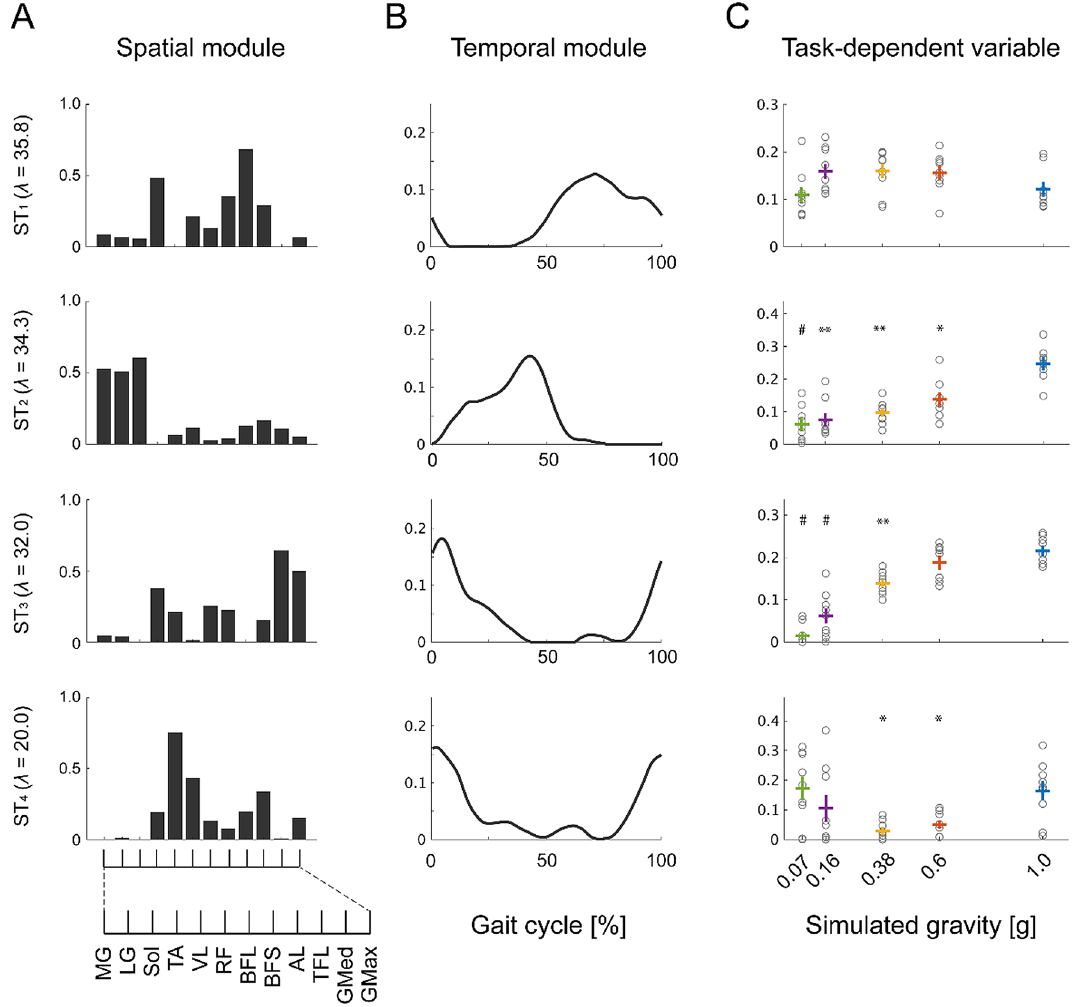
Figure 8. Spatial and temporal modules and task-dependent variables. Spatial ( A ) and temporal ( B ) modules and corresponding task-dependent variables ( C ) extracted from the EMG data tensor at Fr ~ 0.25 are shown. λ denotes the scaling factor. Each circle of the task-dependent variables indicates the data for individual participants. The mean and standard error of the means are represented as horizontal and vertical lines of a coloured crossed line in each gravity level. Symbols (*, #) indicate a significant difference in the task-dependent variables between a gravity condition of 1 g and the other gravity levels; * p < 0.05, ** p < 0.01 and # p <